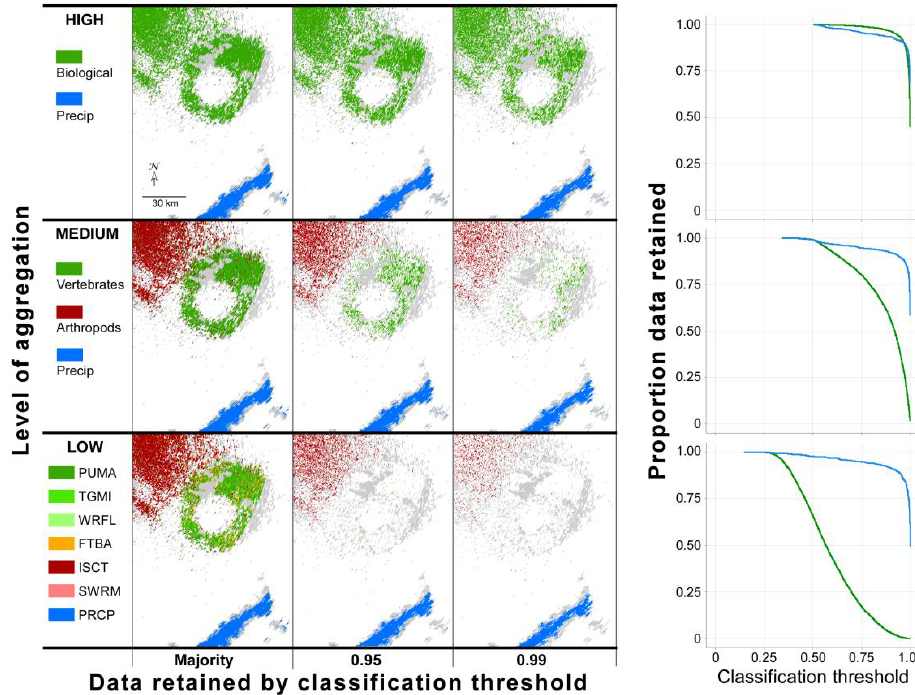
Figure 4. The proportion of radar data retained varied inversely with the classification probability of resolution volumes. Data from a single 0.5° elevation sweep on 13 July 2014 at 10:33 UT from the WSR-88D radar in Columbia, SC (KCAE) classified according to three RF models built using different levels of aggregation. (These data were excluded from RF model training or testing.) The panel of sweeps above-left is dominated by purple martins (green), precipitation (blue), and presumed insects (red), and shows the distribution of resolution volumes exceeding different classification probability thresholds. The left column of sweeps shows the majority classification and middle and right columns show resolution volumes retained with probabilities of classification ≥0.95 and ≥0.99, respectively. Resolution volumes below these thresholds were dropped and are shown as white space. For each level of aggregation, the distribution of resolution volumes on the left represents three points along their respective curves to the right, as shown in blue for precipitation and in green, from top to bottom, for biological, vertebrates, and purple martins.